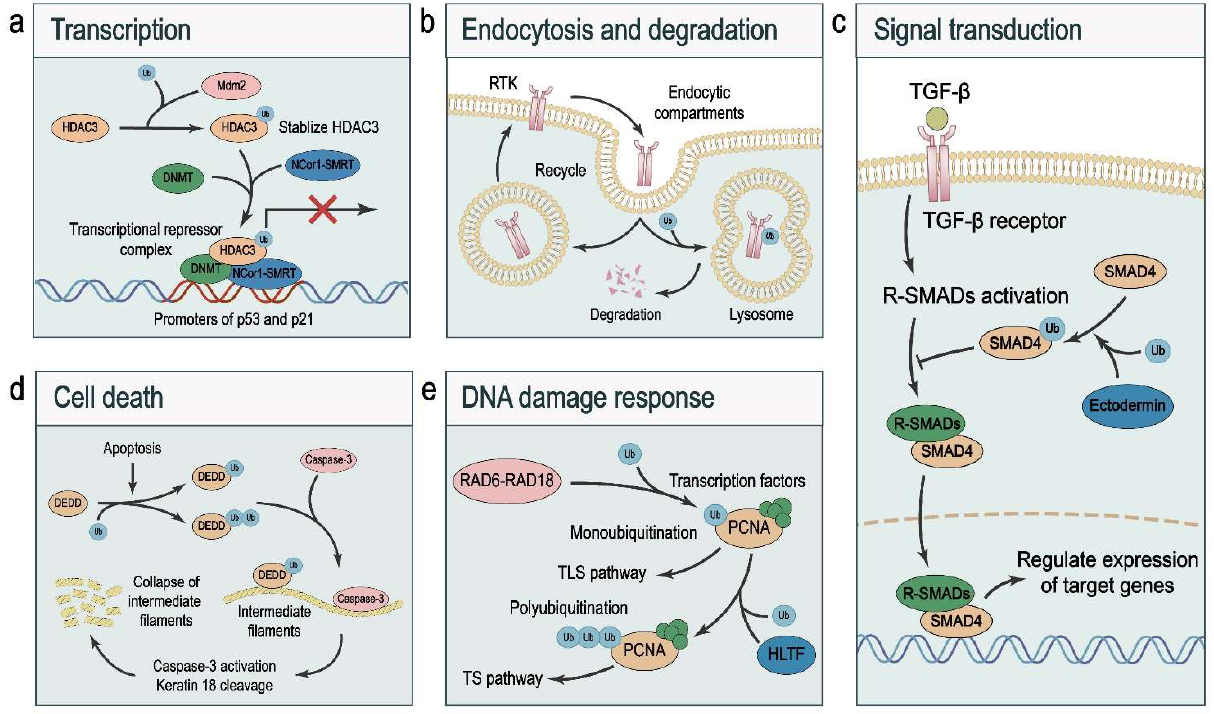
Figure 3. Cellular functions of monoubiquitination. ( a ) Mdm2 binds, monoubiquitinates, and sta- bilizes HDAC3, which forms a complex with co-repressors including DNMT and NCor1–SMRT to repress the transcription of tumor suppressors p53 and p21. ( b ) Monoubiquitinated RTKs are sorted to the lysosomal compartment, limiting their recycling to the plasma membrane. ( c ) TGF- β binds to its receptors to activate R-SMADs, which form a complex with SMAD4. The SMAD complex translocates into the nucleus to regulate target gene transcription. Monoubiquitination of SMAD4 blocks its interaction with phospho-SMAD2, resulting in inactivation of TGF- β signaling. ( d ) In response to proapoptotic stimuli, mono- and di-ubiquitinated DEDD and caspase-3 aggregate on intermediate filaments, leading to activation of caspase-3, cleavage of keratin 18, and collapse of intermediate filaments. ( e ) HLTF mediates PCNA polyubiquitination, and RAD6–RAD18 medi- ates PCNA monoubiquitination. In the presence of HLTF, PCNA monoubiquitination leads to its polyubiquitination, which favors the template switching (TS) pathway; in the absence of HLTF, monoubiquitinated PCNA triggers the translesion synthesis (TLS) pathway.